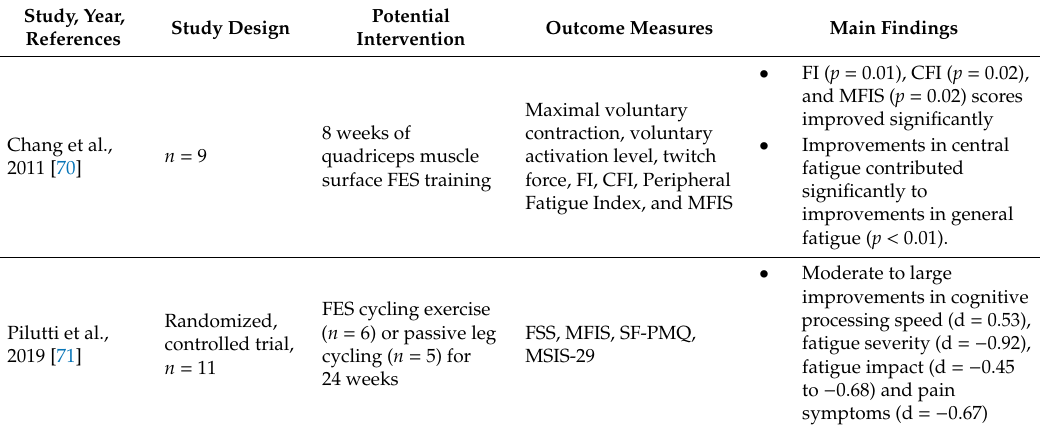
Table 5. Clinical studies of FES in patients with MS-related